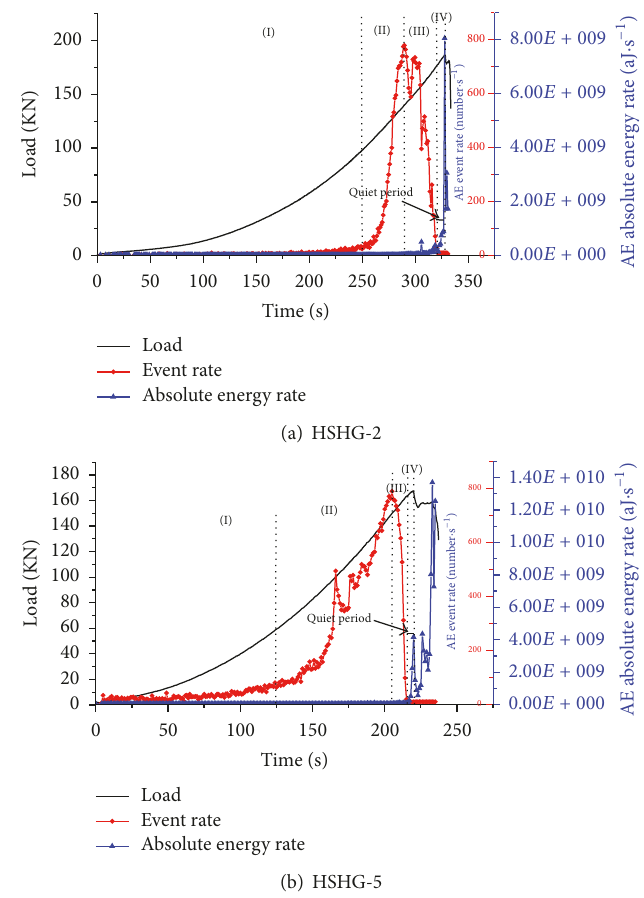
Figure 5: The change curve of load, AE event rate, and the absolute energy rate during the failure process of granite.